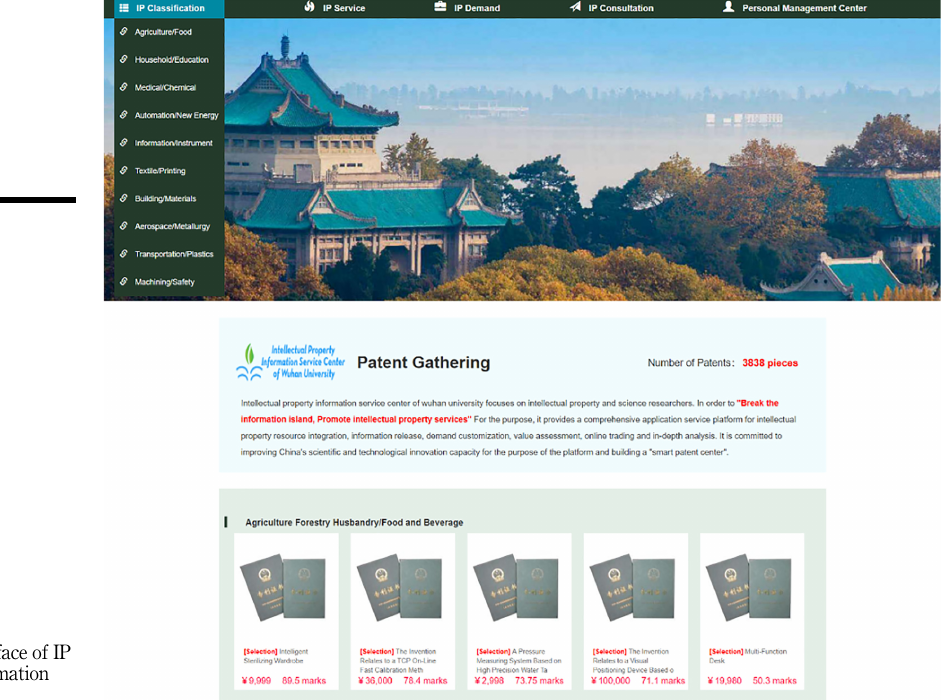
Figure 6. Display interface of